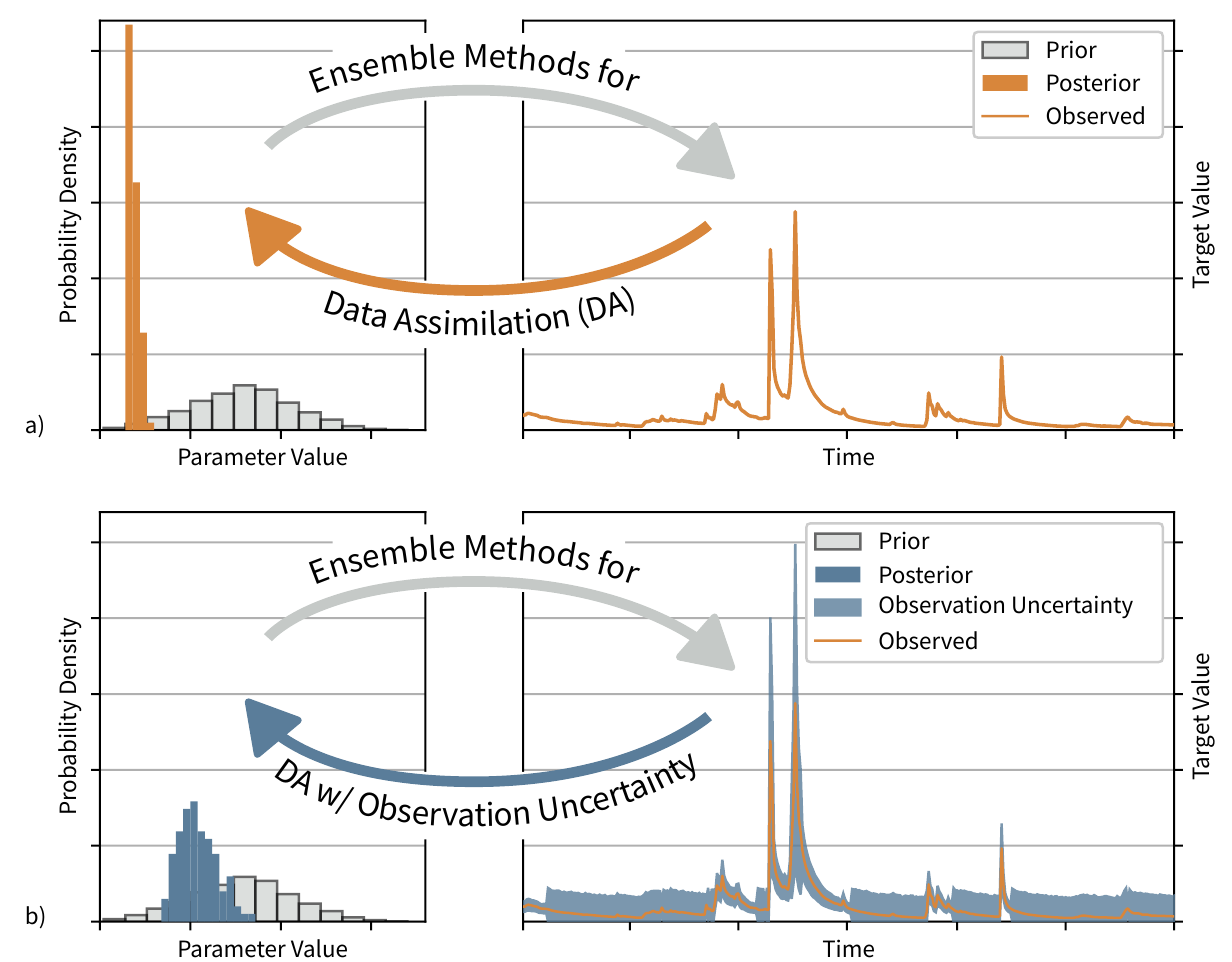
Figure 1. Conceptual schematic of observation error models in data assimilation (DA) and optimizing the bias–variance trade-off. The prior parameter distribution, “Prior”, is estimated using professional judgment with the goal of uncovering a posterior parameter distribution, “Posterior”, that produces numerical model forecasts, which are congruent with observations and that has minimum variance and bias. Panel ( a ) represents the case of no observation error model in DA, where bias is a concern. Here, the range of target values for each history matching interval is narrower than the expected measurement and representation error, causing the inverse solution to overfit to a narrow range of relatively unlikely parameter values as shown on the left-side of panel ( a ). Variance denotes the spread of parameter values in the posterior. The goal of DA is to use observations to constrain, or narrow, the posterior relative to the prior. In panel ( b ), the introduction of observation uncertainty and the use of an observation error model promote a posterior with an expected value within the range of relatively likely prior values from professional judgment and with reduced variance, and thus reduced uncertainty, relative to the prior. Note that a single parameter and target are shown for illustrative purposes. Ensemble methods for DA work with hundreds to millions of parameters and hundreds to thousands of targets